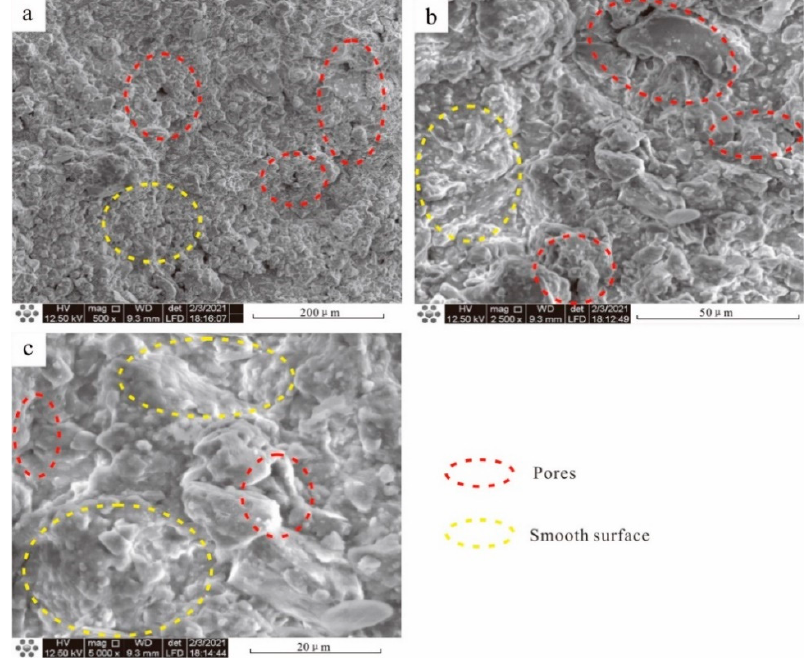
Figure 15. Microstructure of waste mud from slurry shield tunneling.